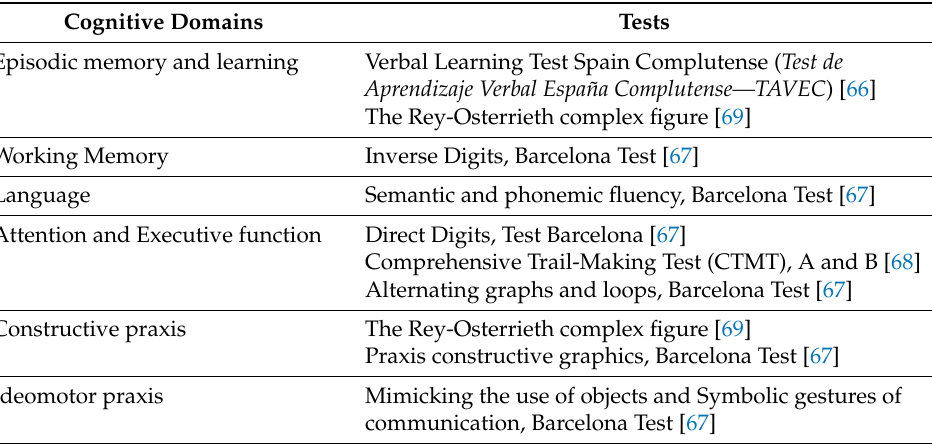
Table 2. Cognitive domains and